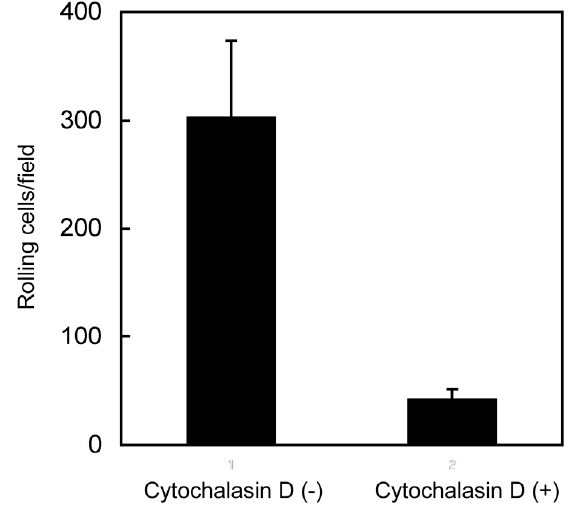
Figure 5. Disruption of the cytoskeletal structure with cytochalasin D abrogates CD44-mediated rolling adhesion under flow conditions. BW5147 T lymphocytes